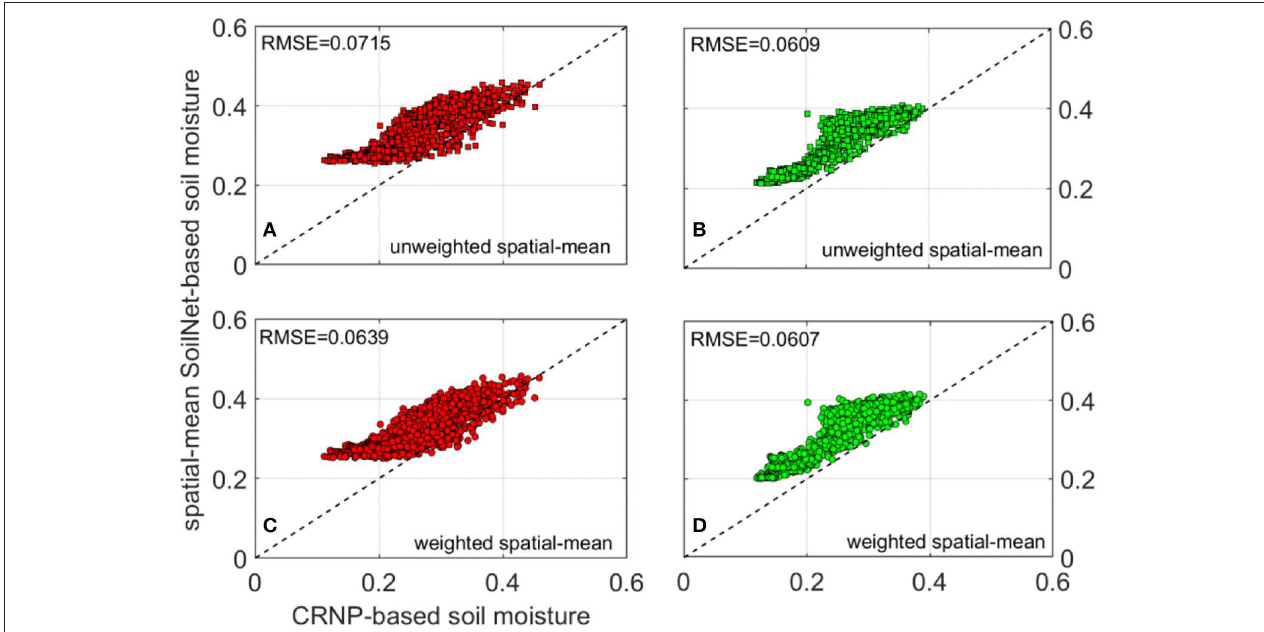
FIGURE 5 | Relation between CRNP-based soil moisture and unweighted spatial-mean of SoilNet-based soil moisture at (A) MFC2; (B) GOR1; relation between CRNP-based soil moisture and weighted spatial-mean of SoilNet-based soil moisture at (C) MFC2; (D) GOR1. Dashed black line depicts the 1:1 identity line. RMSE values are reported in each subplot.